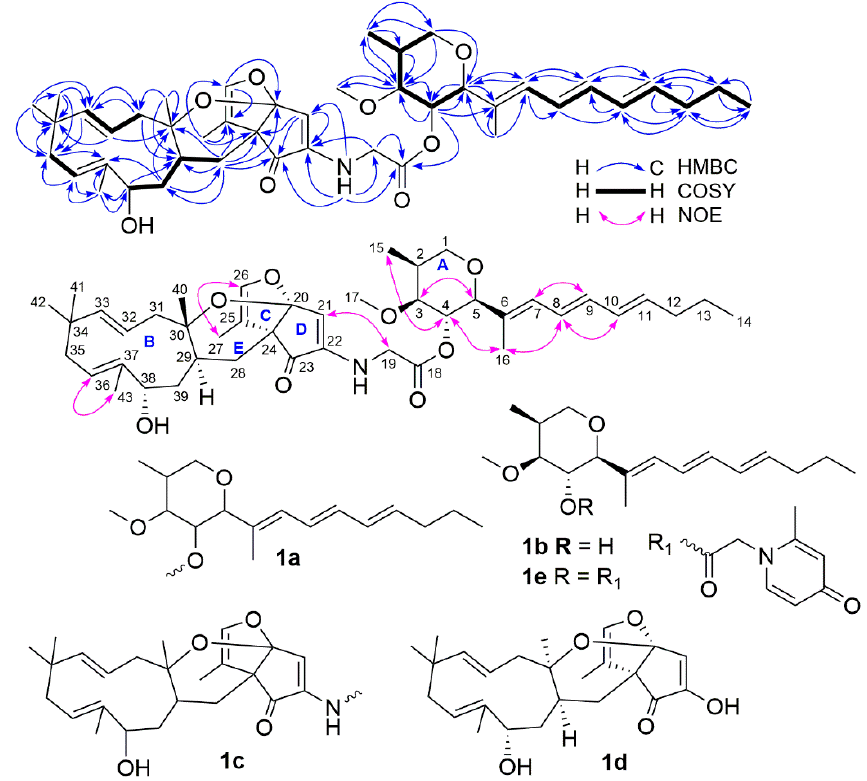
Figure 2. COSY, key HMBC, and NOE correlations of penipyridinone B ( 1 ) and structures of 1a – 1e .